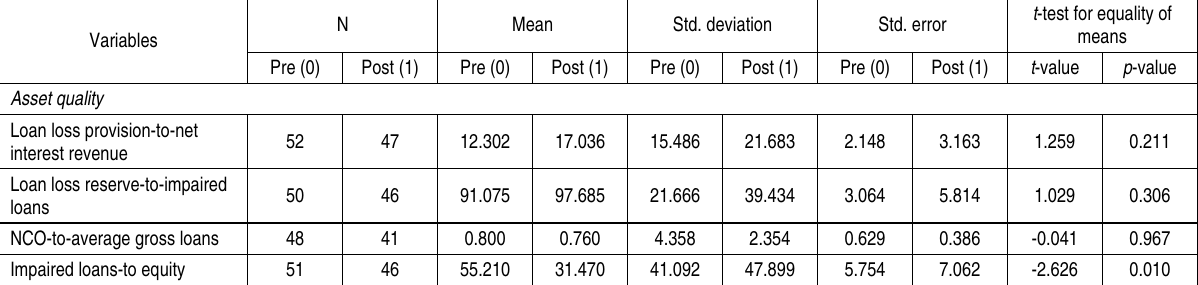
Table 2. Descriptive statistics for the 15 banks pre- and post- M&A using financial ratios Variables